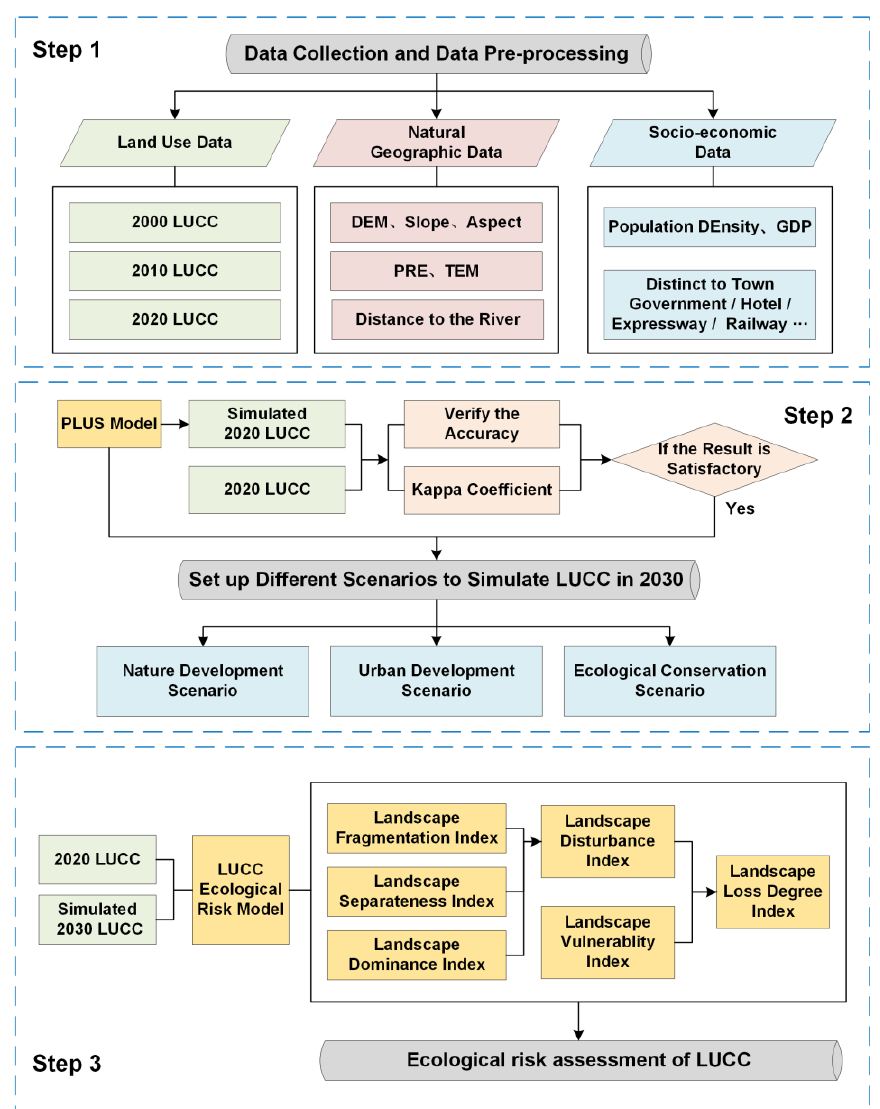
Figure 2. Landscape Ecological Risk Assessment Framework of Land Use Change in Xinjiang.